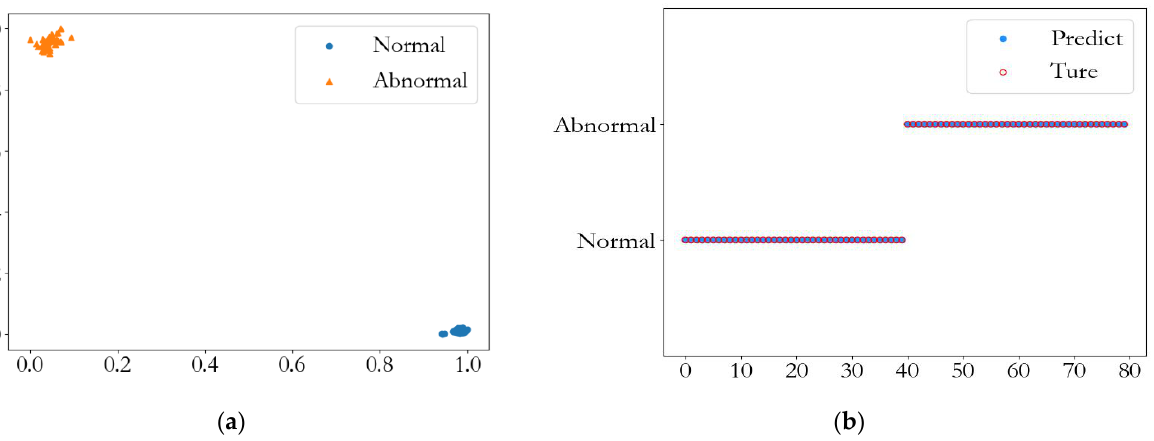
Figure 13. Actual machine experiment results: ( a ) visualization results of hydroelectric-unit signal characteristics; ( b ) diagnosis results for the fault signal from hydroelectric units.